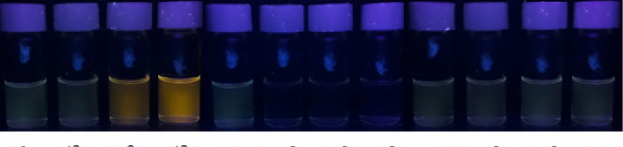
Figure 8. Change in the fluorescence of tolan ( 2b , 10 µ M) in PBS buffer (10 mM, pH 7.2) containing 50% MeOH, 10 min after the addition of each metal (2 equiv.) under a laboratory hand-held UV lamp. Three individual photos were